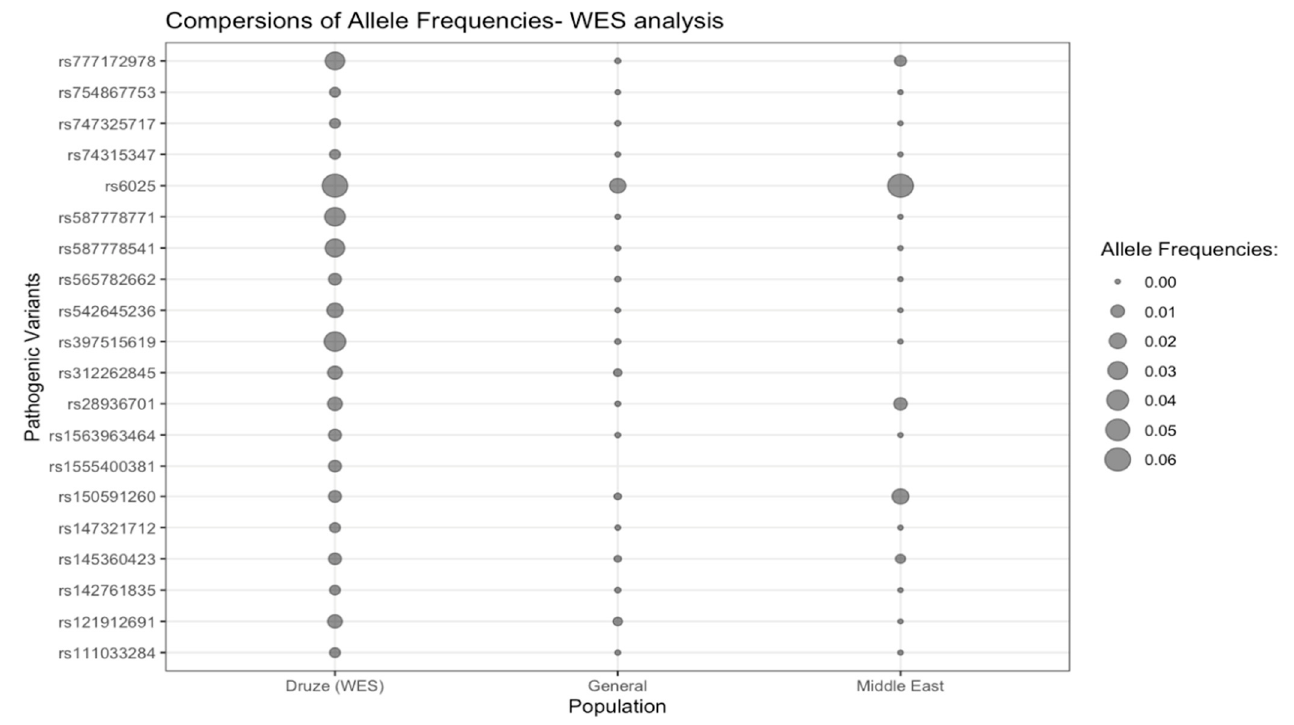
Figure 2. Bubble plot representing the AF of each PV according to the WES analysis and with respect to Druze, General, and Middle East populations. Missing allele frequencies are represented by missing bubbles.